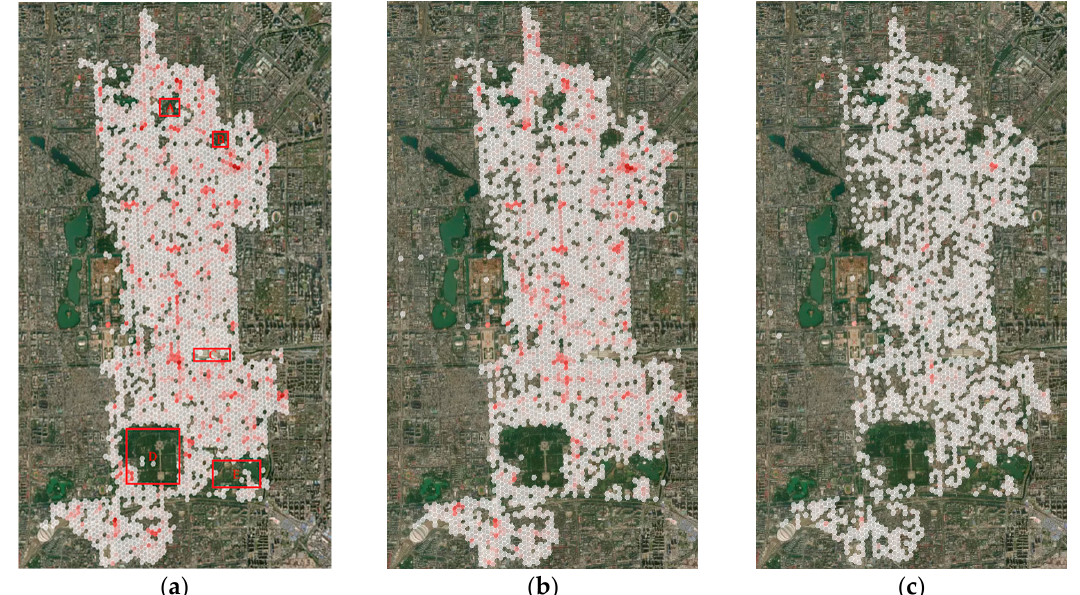
Figure 14. Visualization results for the bike-sharing data from Dongcheng district in Beijing using the indexing algorithm proposed in this paper: ( a ) from 8:00 to 9:00, where areas from A to E are Ditan park, the Russian Embassy, Beijing railway station, Temple of Heaven Park, and Longtan Park, respectively; ( b ) from 17:00 to 18:00; and ( c ) from 20:00 to 21:00.